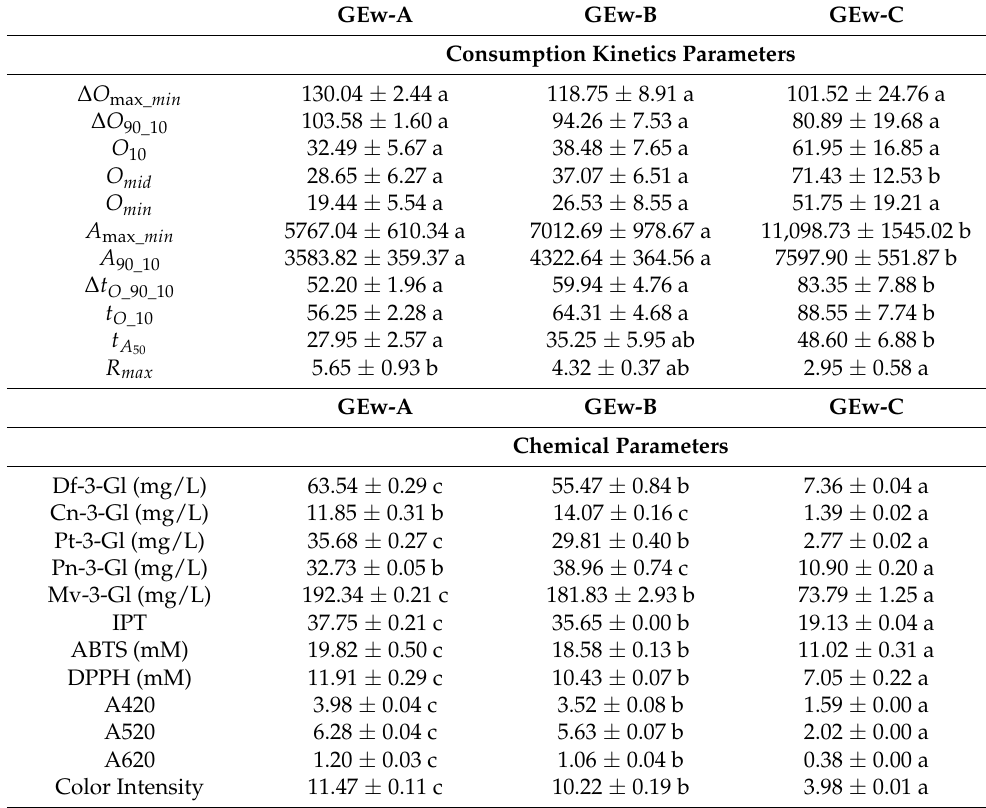
Table 5. Data of consumption kinetics parameters and initial chemical parameters of each GEw (A, B and C) in condition